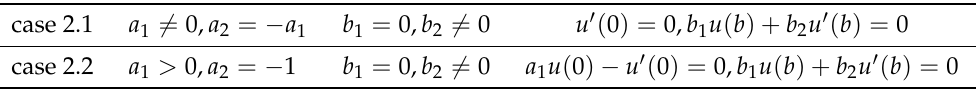
Table 5. Examples of Sturm–Liouville problems with a = 0, b > 0, x ∈ ( 0, b ) , case 2: a 1 · a 2 (cid:54) =